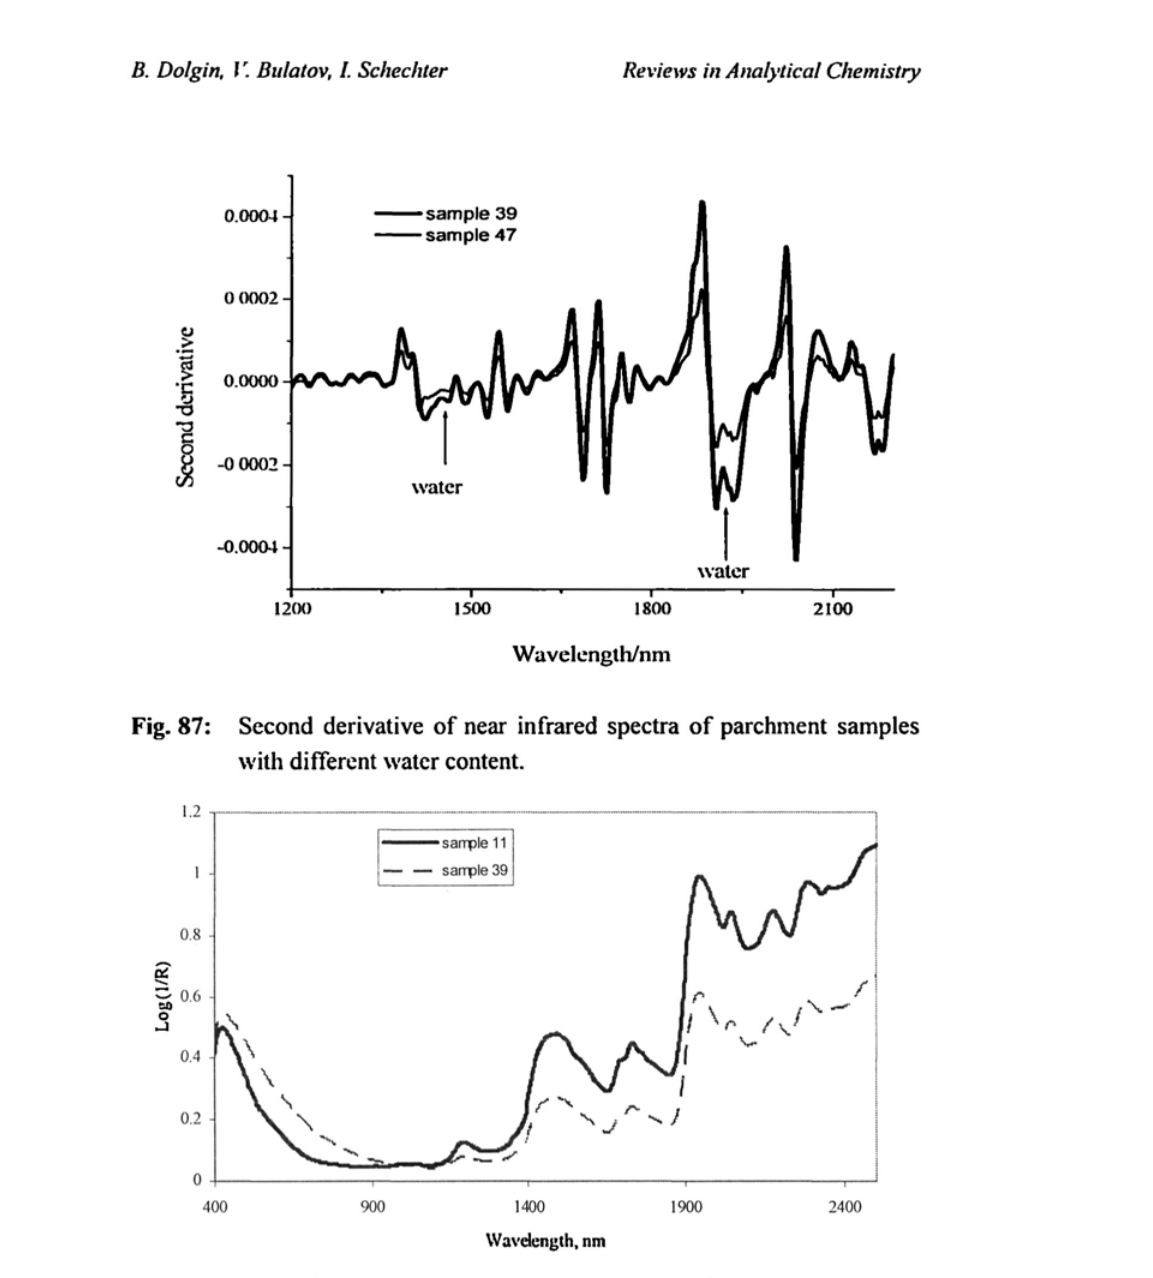
Fig. 88: Near infrared spectra of parchment samples with different nitrogen